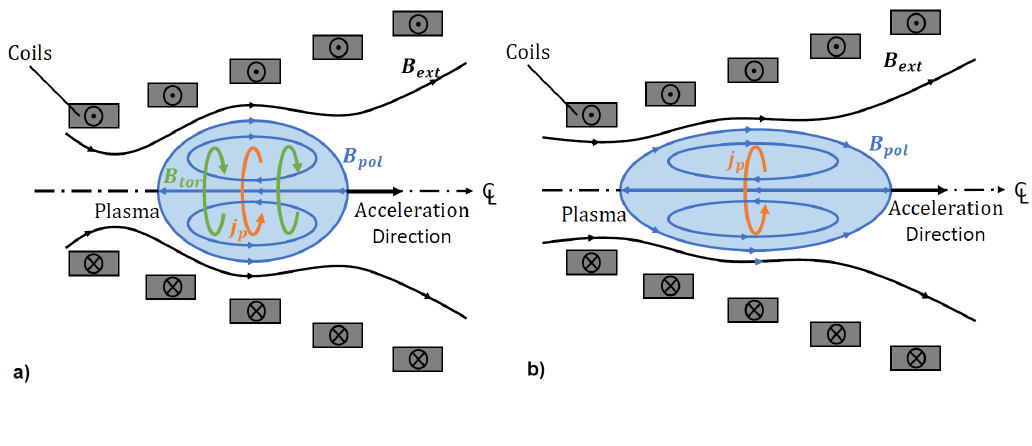
Figure 7. Schematic illustrations of conical coil sets containing ( a ) a spheromak plasma and ( b ) a field-reversed configuration (FRC) plasma, showing the directional sense of the current in the coils, the azimuthal plasma current j p , and poloidal magnetic field B pol , the magnetic field external to the plasma B ext , and the toroidal magnetic field B tor in the spheromak